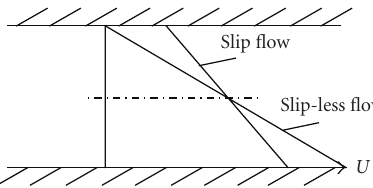
Figure 2: Velocity profiles and the flow rates of the slip-less and slip Couette flows (the transitional case also is symmetric relative to the central line but is not shown